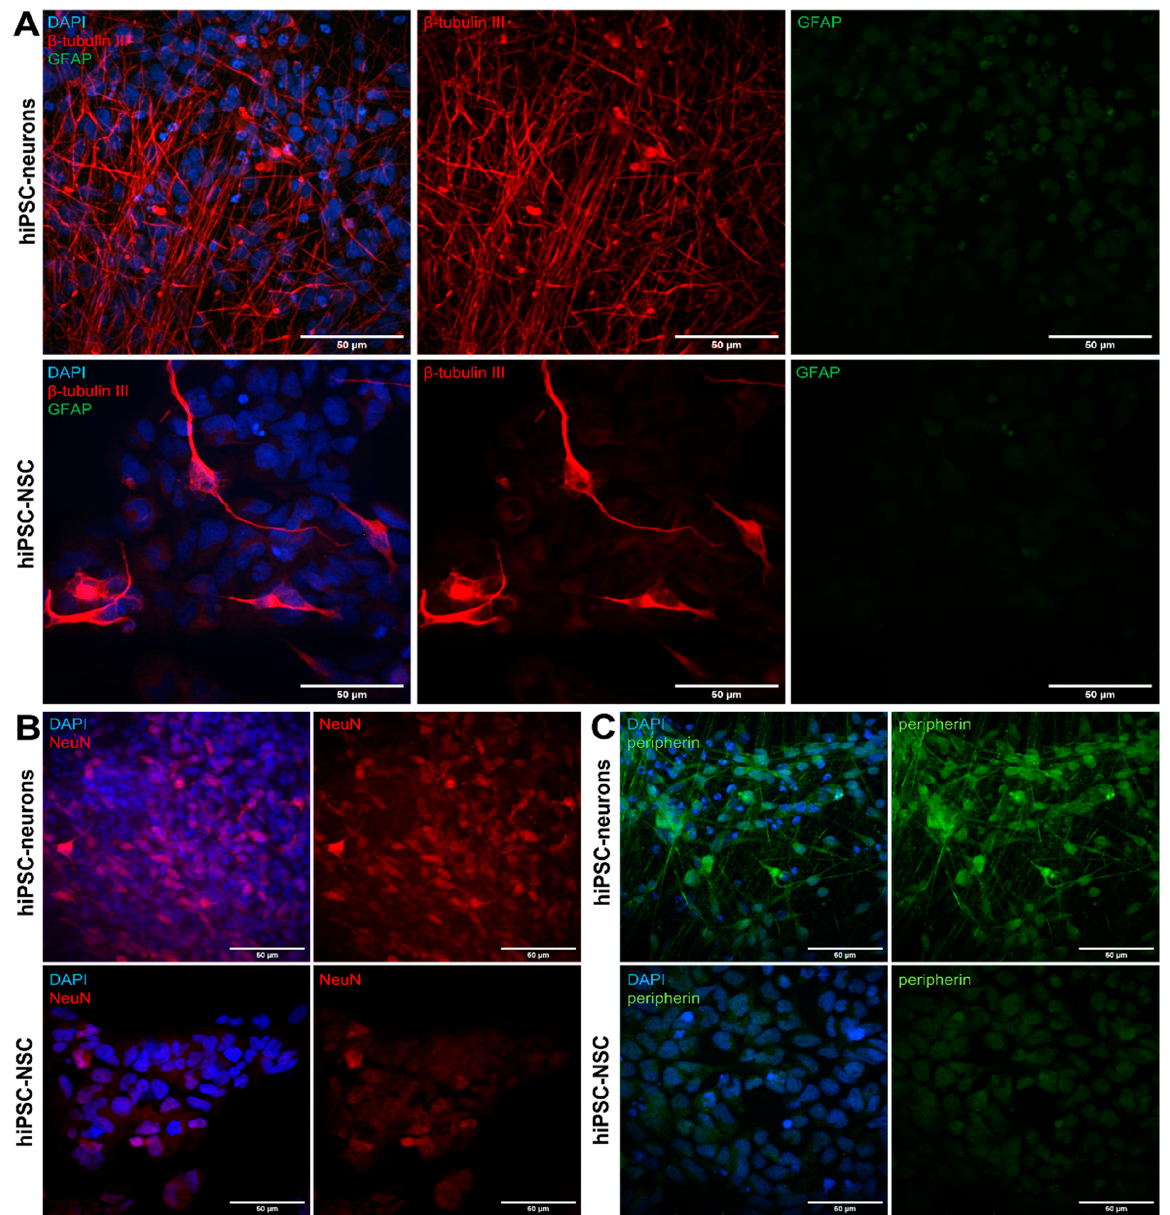
Figure 1. Differentiation of hiPSC-NSCs into peripherin-expressing hiPSC neurons. ( A ) hiPSC-NSCs and hiPSC neurons were stained with mouse anti- β -tubulin III and rabbit anti-GFAP primary antibodies in combination with goat anti-mouse AF555 (red) and goat-anti rabbit FITC (green) secondary antibodies. Nuclei were stained with DAPI (blue). Representative images from three independent repeats of hiPSC-NSCs at DIV 2 and hiPSC neurons at 21 dpd. ( B ) hiPSC-NSCs and hiPSC neurons were stained with guinea pig anti-NeuN and secondary donkey anti-guinea pig Cy3 (red) antibody. Nuclei were stained with DAPI (blue). Representative images from three independent repeats of hiPSC-NSCs at DIV 2 and hiPSC neurons at 21 dpd. ( C ) hiPSC-NSCs and hiPSC neurons were stained with chicken anti-peripherin and secondary goat anti-rabbit FITC (green) antibody. Nuclei were stained with DAPI (blue). To verify specificity of the neuronal markers, secondary antibody controls were prepared for hiPSC-NSCs and hiPSC neurons (data not shown). Representative images from three independent repeats of hiPSC-NSCs at DIV 2 and hiPSC neurons at 21 dpd.